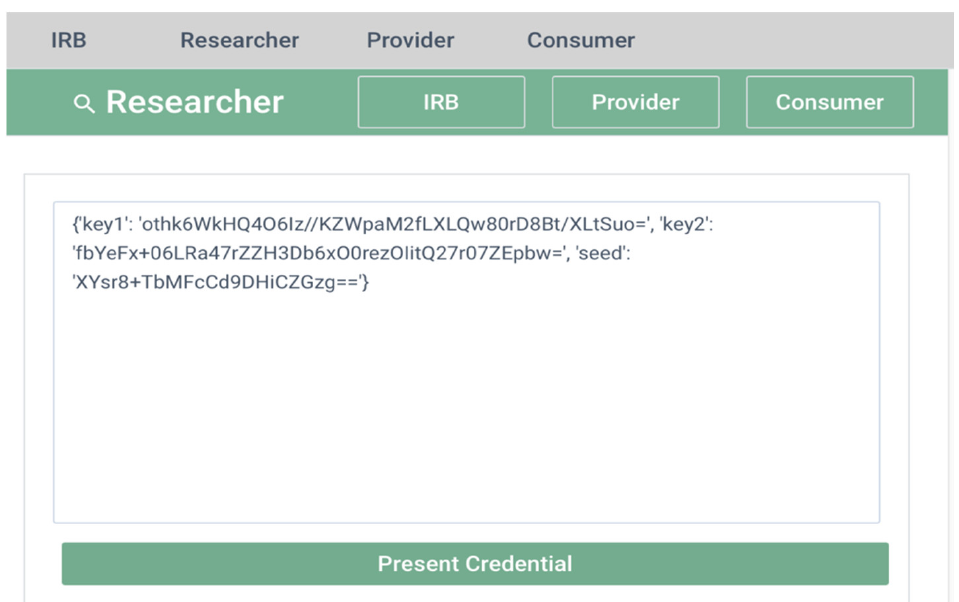
Figure 16. VC offered by the CDM provider after delivering CDM encrypted.